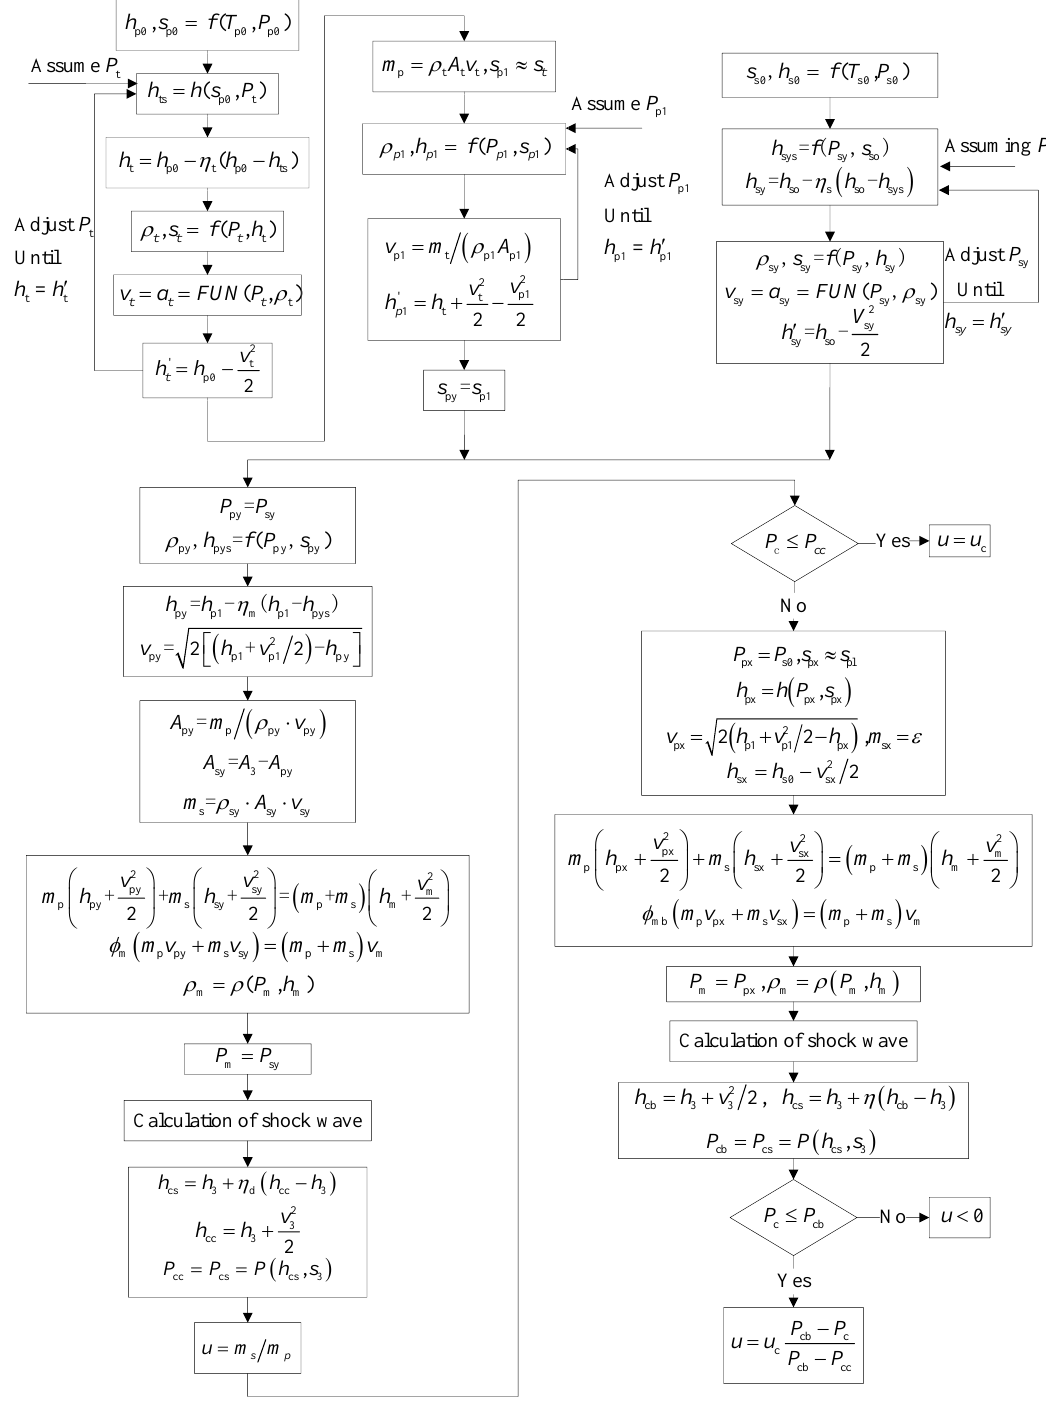
Figure 5. The flowchart of